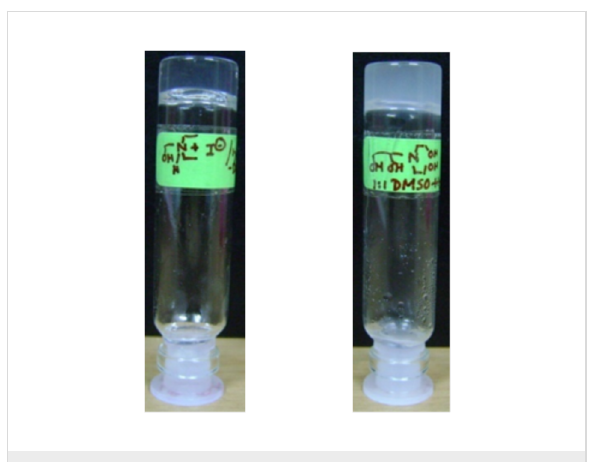
Figure 1: Photographs of the gels: 1 in 1,2-dichlorobenzene (0.2% w/v, left); 2 in 1:1 DMSO/water (0.3% w/v, right).